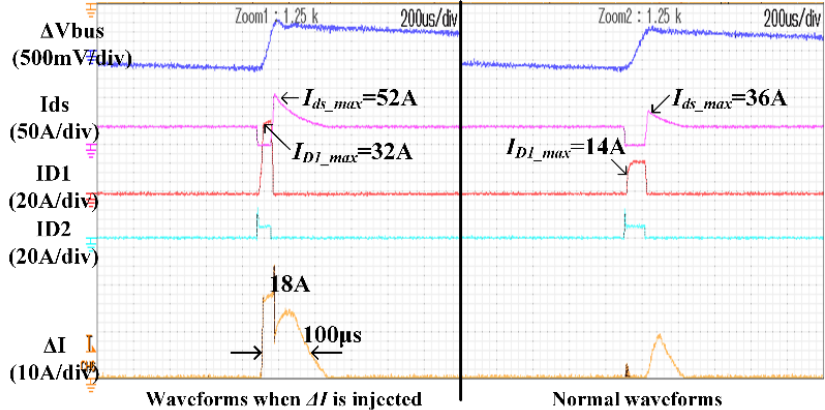
Figure 20. ∆ I is injected during the off-time of MOSFET. Figure 20. Δ I is injected during the off ‐ time of MOSFET. The power loss of the shunt MOSFET due to unexpected energy compared to normal operation is shown in Figures 21 and 22. Due to the unexpected energy for solar array, the peak power loss during both the turn-on and turn-off of the MOSFET increases significantly.